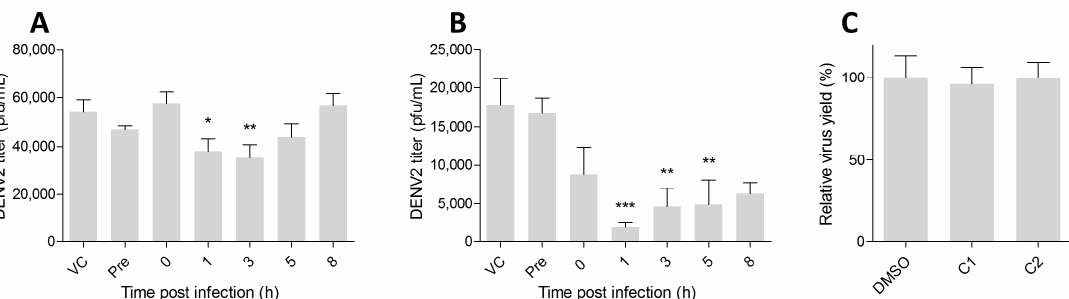
Figure 4. Time-of-addition analysis ( A , B ) and effects of active compounds on the virucidal activity assay ( C ). Compound 1 ( A ) or compound 2 ( B ) was added at several time points during DENV2 infection of Vero cells, as described in Materials and Methods. VC: virus control, infected without compound, with a multiplicity of infection (MOI) = 0.5. Pre: compounds were added to cell monolayers for 1 h before infection, and then removed. 0: compounds were incubated with the cells for 1 h, during the virus adsorption, then removed. 1–8: compounds were added at 1–8 h and kept for 48 h post infection. Then supernatants were collected and the titer was determined by plaque assays. For the virucidal activity assay ( C ), DENV2 aliquots containing 10 5 pfu were incubated with either compound 1 , compound 2 , or vehicle for 1 h. Then the virus was diluted in maintenance medium and the viral titer determined by plaque assays. Data is expressed as mean ± standard error of three independent experiments. Statistical analysis was done as detailed in Materials and Methods. Statistically different means from the value of the virus control sample are marked as (*) p < 0.05, (**) p < 0.01 or (***) p < 0.001